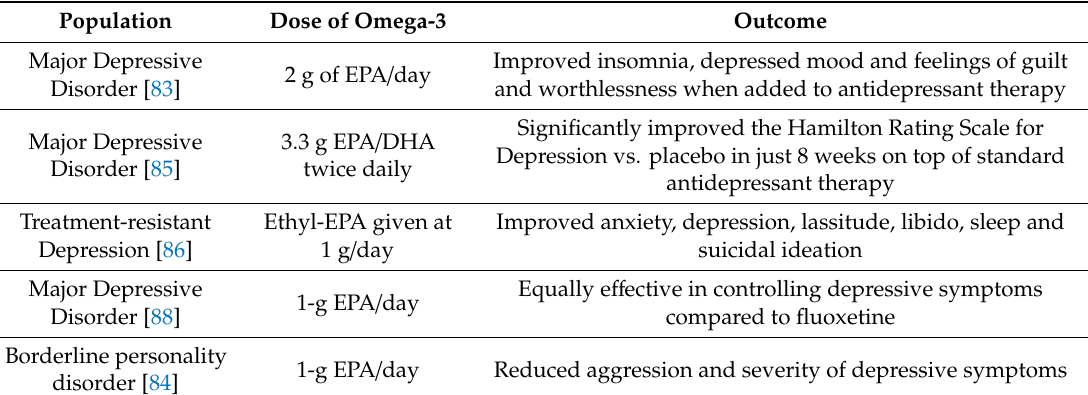
Table 3. Key Clinical Studies Testing Marine Omega-3s in Depression and Borderline Personality Disorder. Population Dose of Omega-3 Outcome Improved insomnia, depressed mood and feelings of guilt Major Depressive 2 g of EPA / day and worthlessness when added to antidepressant therapy Disorder [83] Significantly improved the Hamilton Rating Scale for Major Depressive 3.3 g EPA / DHA Depression vs. placebo in just 8 weeks on top of standard Disorder [85] twice daily antidepressant therapy Treatment-resistant Ethyl-EPA given at Improved anxiety, depression, lassitude, libido, sleep and Depression [86] 1 g / day suicidal